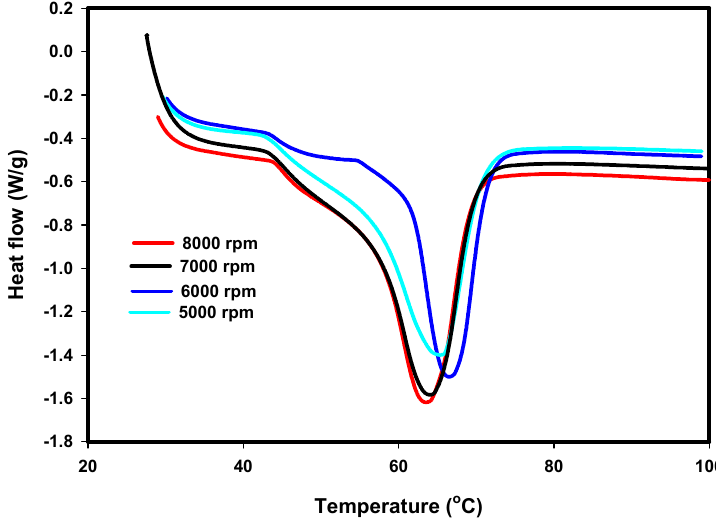
Figure 13. Melting endotherm of PCL fibers prepared by the Forcespinning® of 12.5 wt% PCL/THF solutions at different rotational speeds.